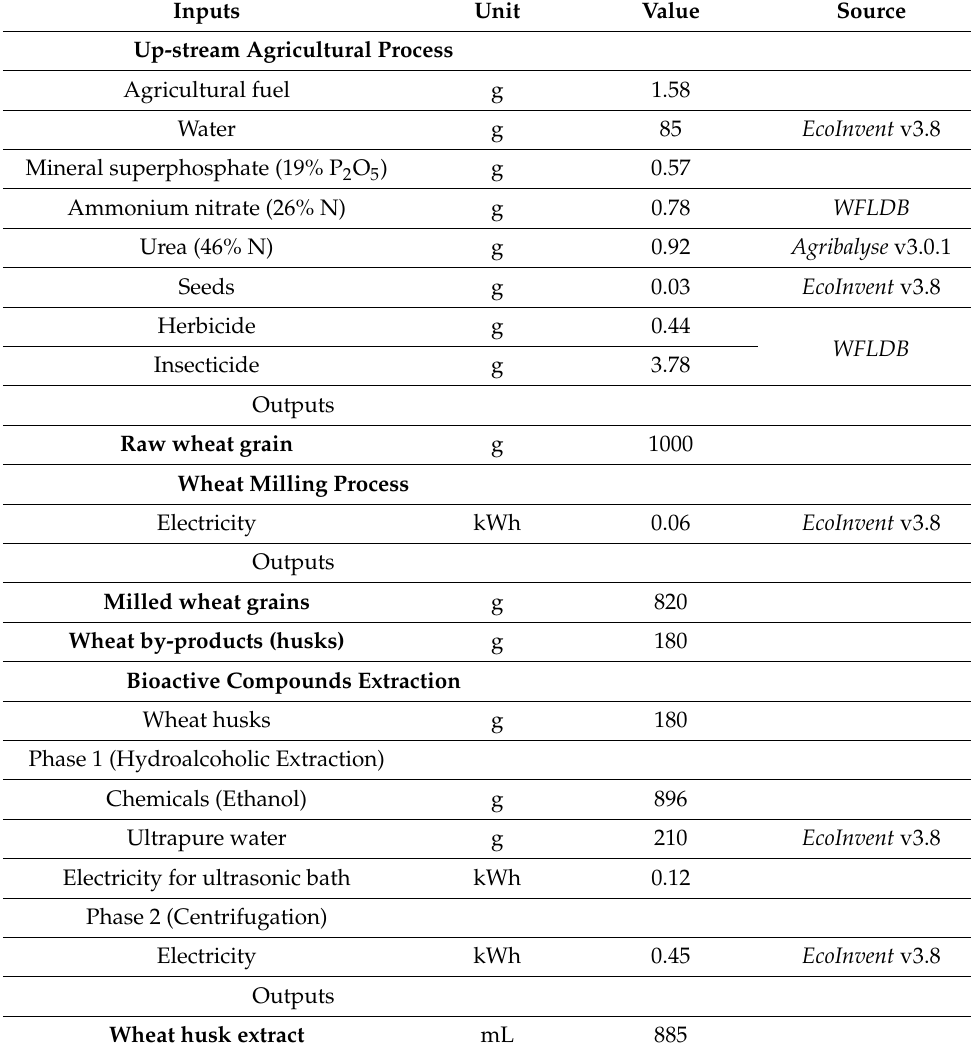
Table 2. Life cycle inventory for the wheat husk system production and recycling scenarios. Inputs referred to FU: 180 g of wheat